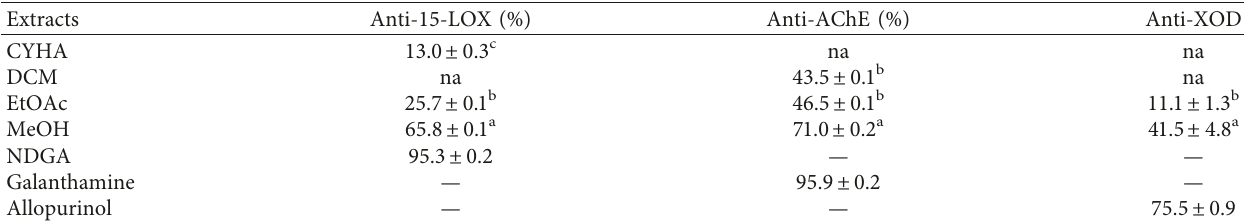
Table 6: Anti-15-LOX, anti-AChE, and anti-XOD activities of M. mabokeensis Aubr´ev bark extracts (50 μ g/mL). Extracts